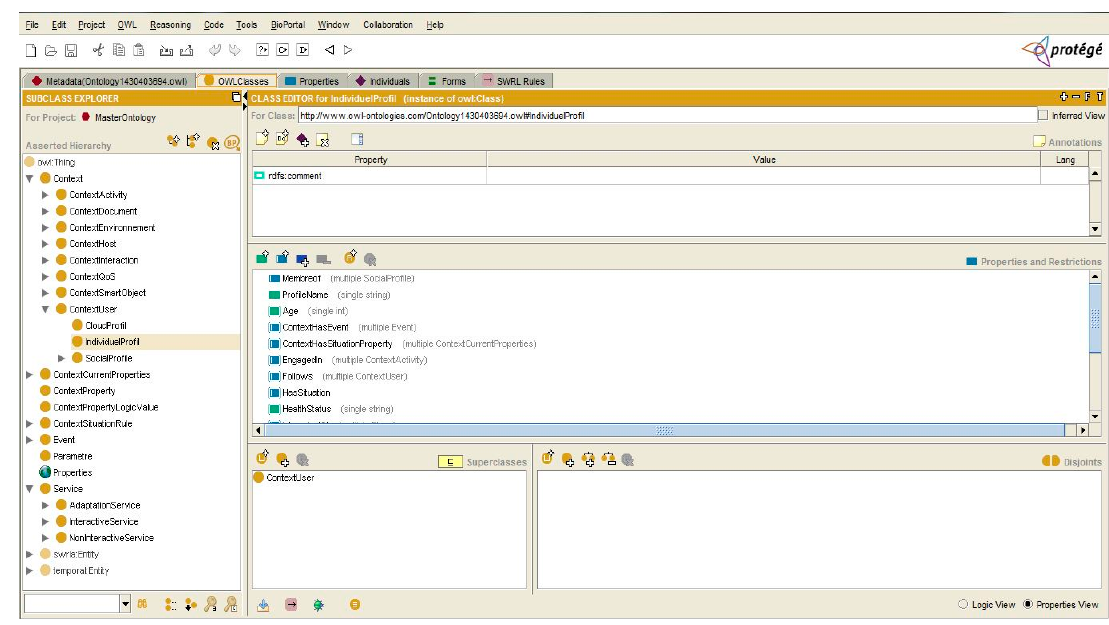
Figure 14. Implementation of our ontology.